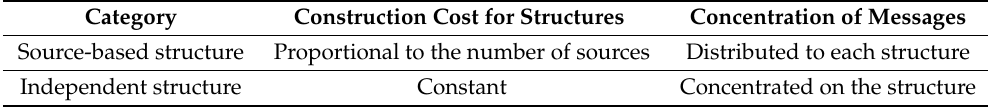
Table 1. Evaluation about sink mobility support schemes for continuous object